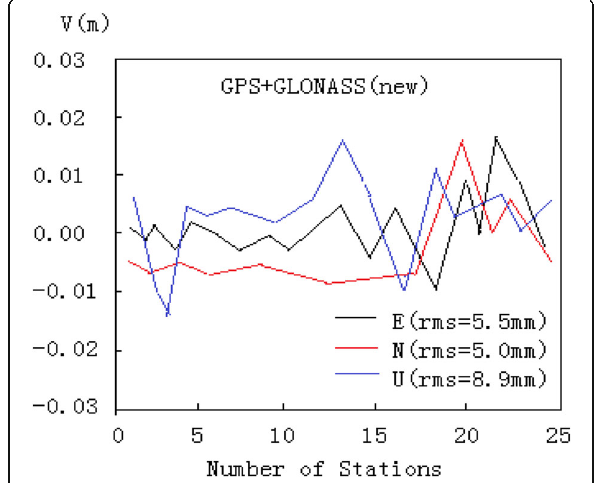
Fig. 4 Positioning result deviation and RMS value of case